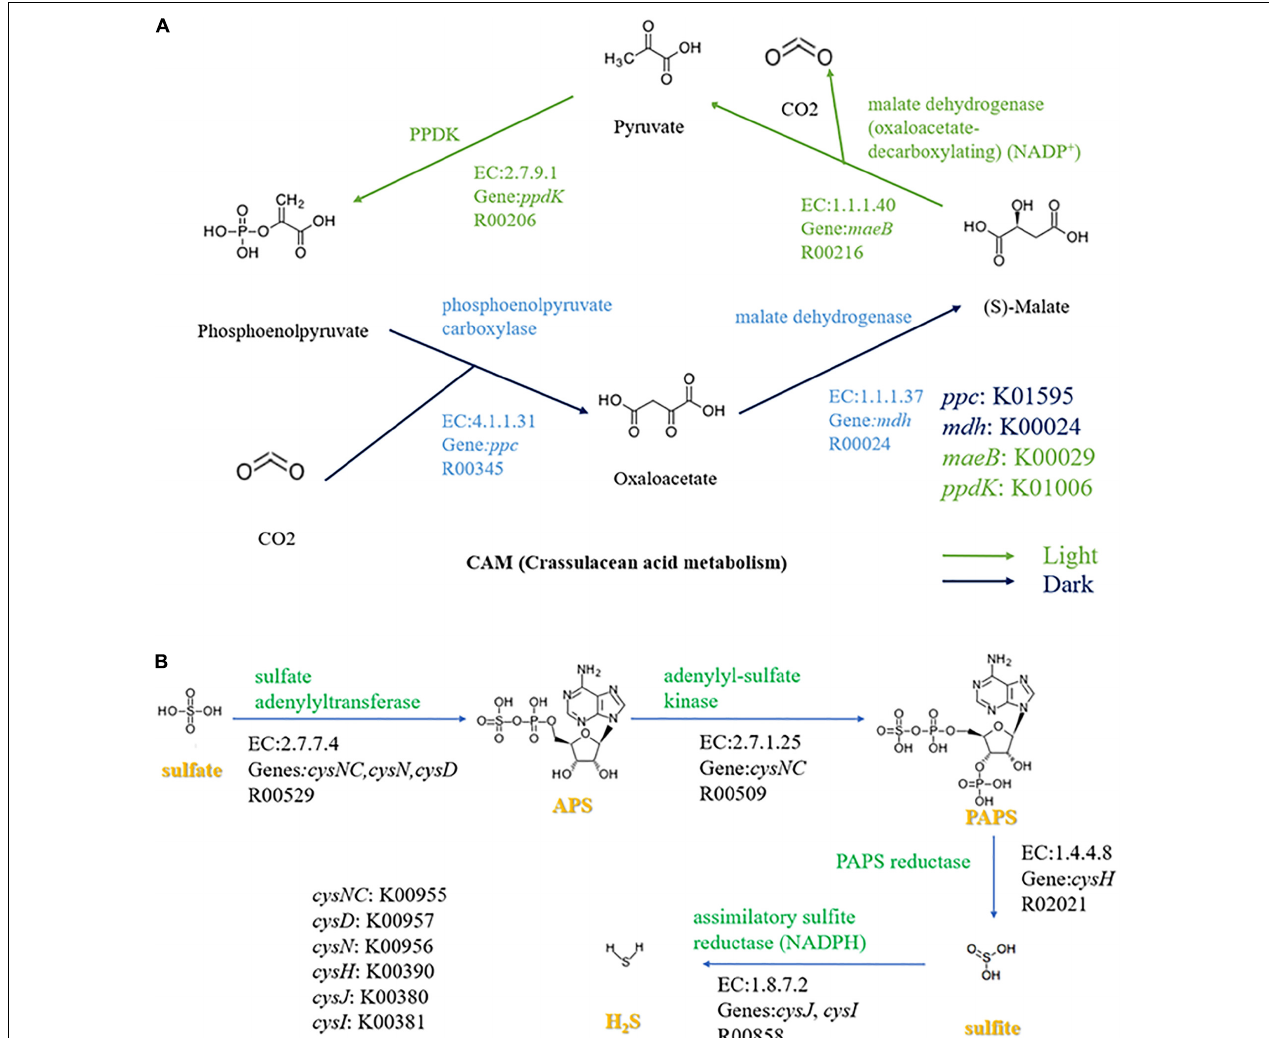
FIGURE 4 | Carbon and sulfur metabolism of Carboxylicivirga strains N1Y132 T , C. sediminis JR1 T , C. linearis FB218 T , and C. mesophila JCM 18290 T . (A) Crassulacean acid metabolism (CAM) cycle in dark and light of four strains in genus Carboxylicivirga . The green arrows and blue arrows indicate the progression of light and dark reactions, respectively. (B) Assimilatory sulfate reduction pathway in Carboxylicivirga species based on KEGG analysis. Other reactants and products have been omitted.